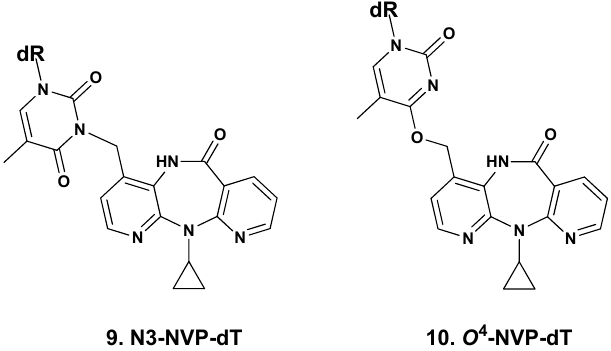
Figure 2. Structures of the NVP adducts, N3-NVP-dT ( 9 ) and O 4 -NVP-dT ( 10 ), isolated from reaction of 12-bromo-NVP ( 8 ) with 3',5'- O -bis( tert -butyldimethylsilyl)-dT under palladium(0) catalysis. dR =